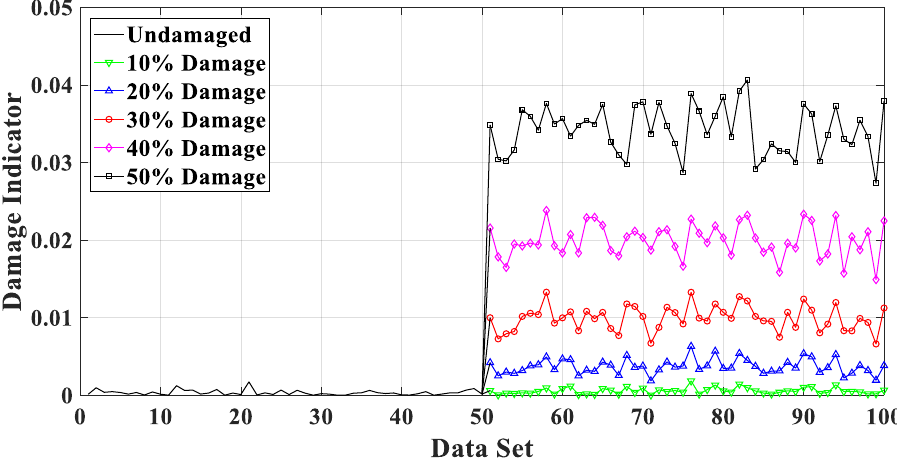
Figure 14. Damage detection for sudden structural change.